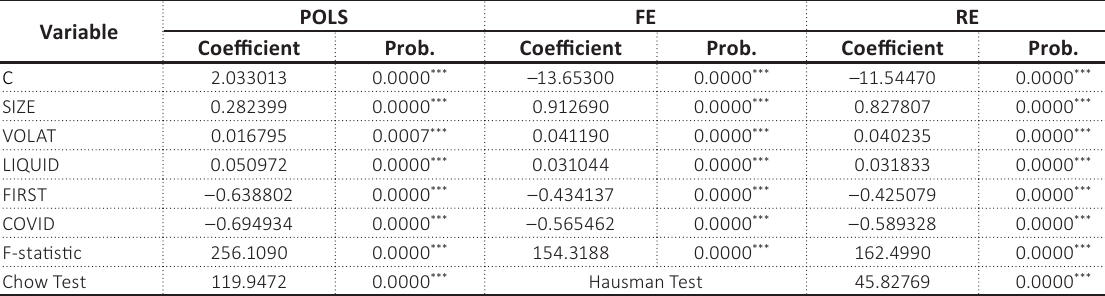
Table 6. Panel regression model results Variable